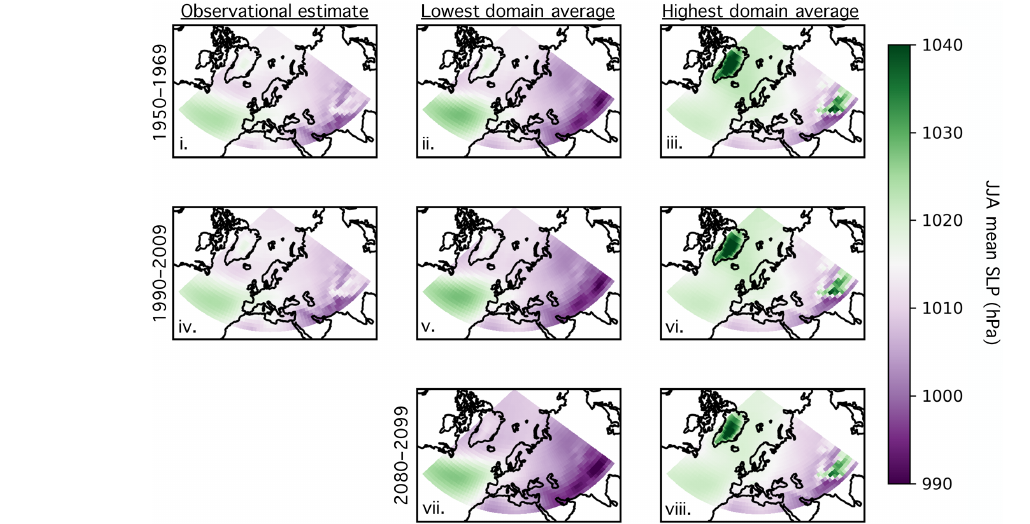
Figure C4. As in Fig. C3, but for JJA SLP